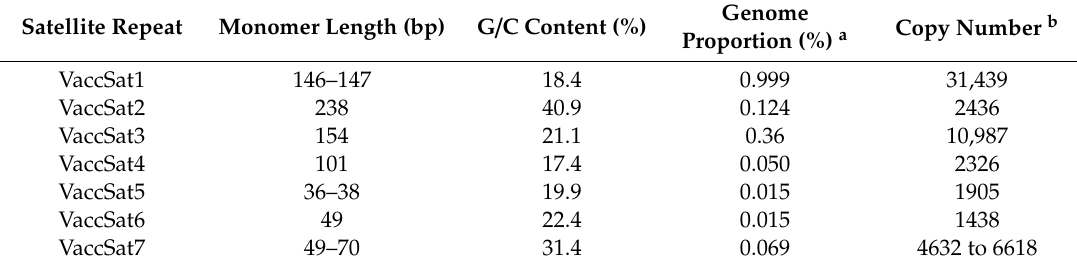
Table 3. Characteristics of Vaccinium satellite repeats as detected by read cluster analysis of diploid V. corymbosum strain W8520